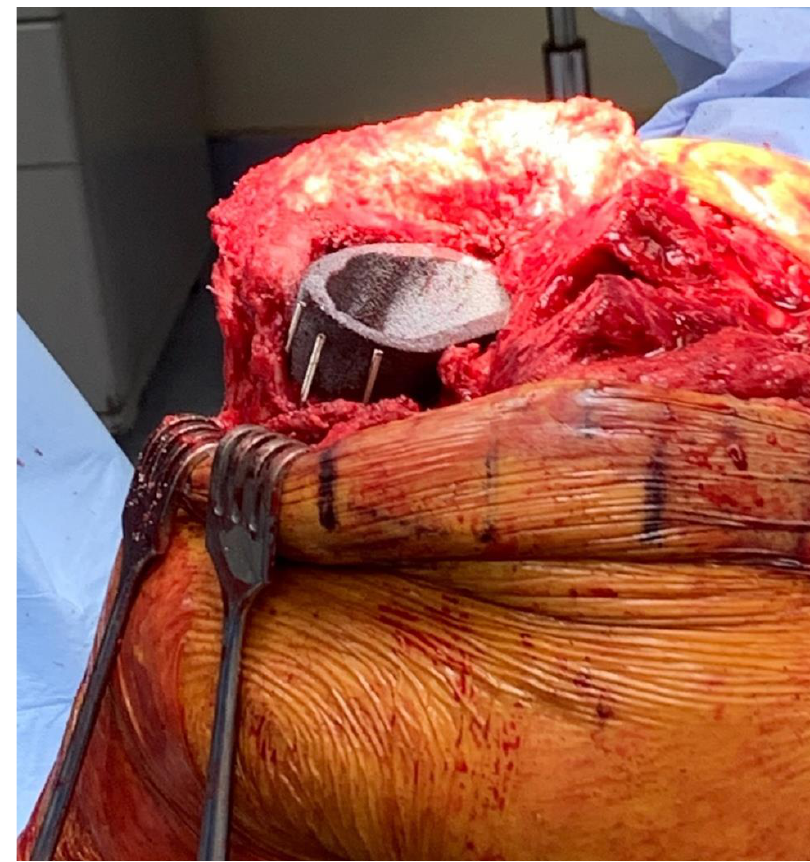
Figure 3. Depiction of four threaded Steinmann pins placed vertically into the proximal tibia, surrounding the metaphyseal cone.